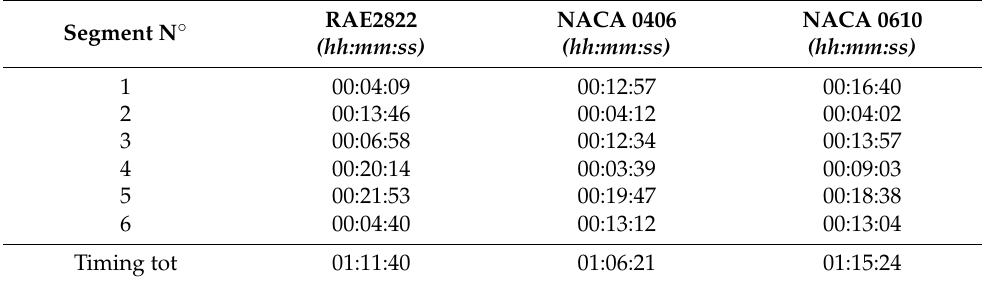
Table 10. New mathematical model fitting process segment-wise computation time.